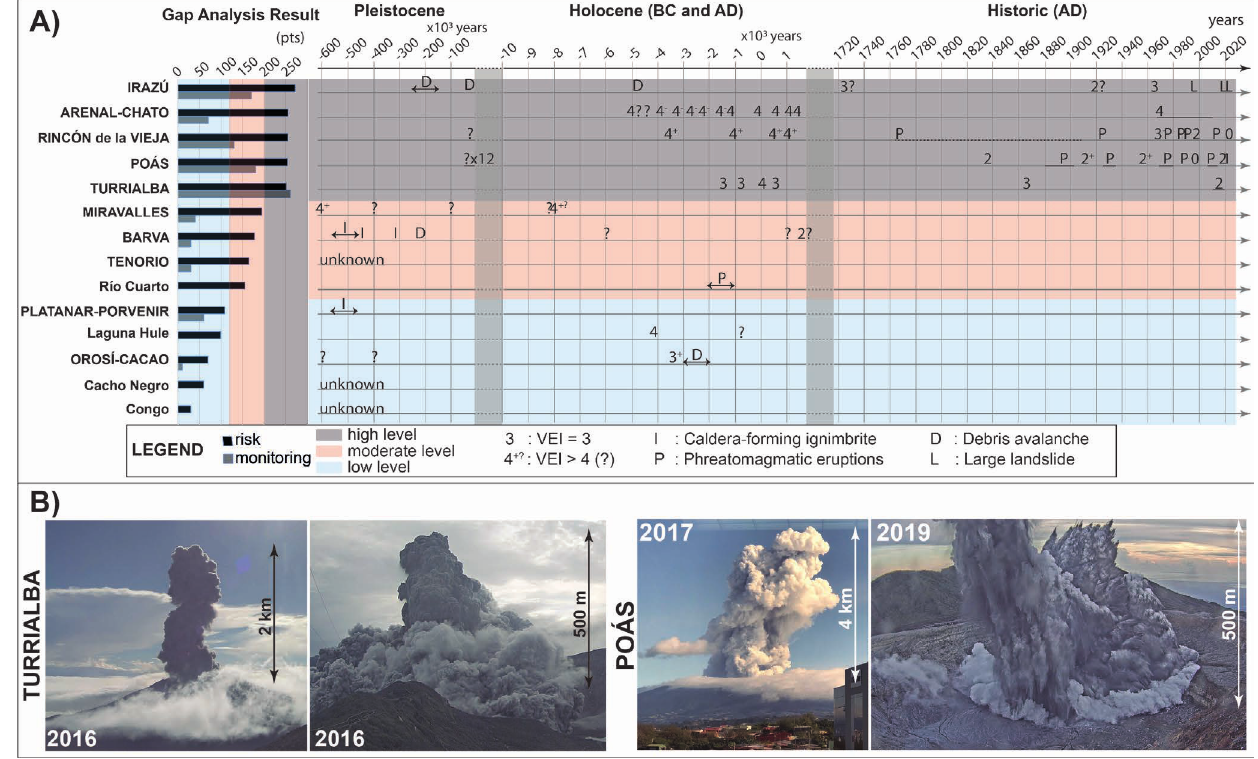
Figure 2: [A] Chronology of the known or estimated eruptive activity in Costa Rica with corresponding possible VEI (Volcanic Explosivity Index; compiled from many sources), and the results of a Gap Analysis in 2020 (see details in Section 5). Dates are negative Before Christ (BC) and positive Anno Domini. Grey vertical bands show a change in the time scale, question marks refer to uncertainties on the magnitude of the event when associated to a number, or to the date of the deposit for which no VEI can even be estimated. P: corresponds to a period of frequent phreatomagmatic eruptions for which no VEI can be estimated. I and D: ignimbrite and debris deposits (respectively) with no VEI estimation. L: large landslide not associated to eruptive activity but still representing a hazard. “Unknown” refers to a complete lack of knowledge of past activity. [B] Left: Phreatomagmatic eruptions at Turrialba volcano in 2016 showing a 2,000 m-high eruptive column on the left and small pyroclastic currents due to column collapse on the right. Right: phreatomagmatic eruptions at Poás volcano on April 14, 2017 (left) taken from the Central Valley 30 km away, showing a 4 km-high vapor-rich plume. This eruption modified the topography of the crater with the destruction of the 1955 dome. On the right, a moderate phreatomagmatic eruption (the jet reached a height of about 500 m) taken from the edge of the crater 600 m away on September 30, 2019. Centimeter-sized ballistics reached the MultiGAS station 400 m downwind from the vent. All pictures were taken by the OVSICORI- UNA webcams except Poás 2017 (credit: Jorge Villalobos